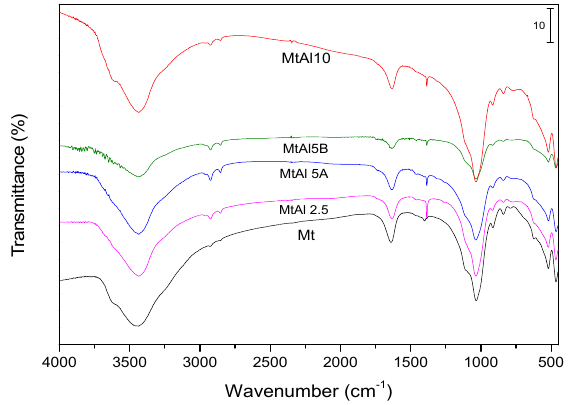
Figure 2. FT-IR spectra of the intercalated solids.